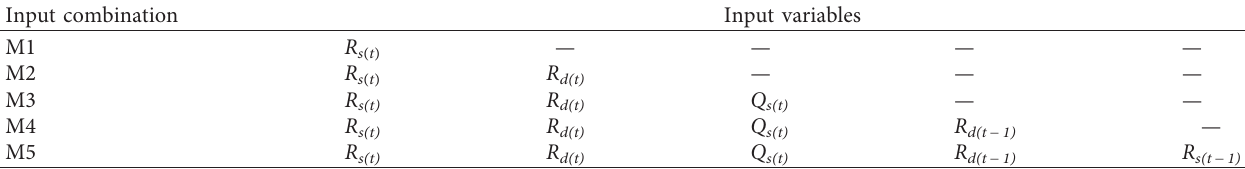
Table 3: The input combinations used for the development of prediction models.